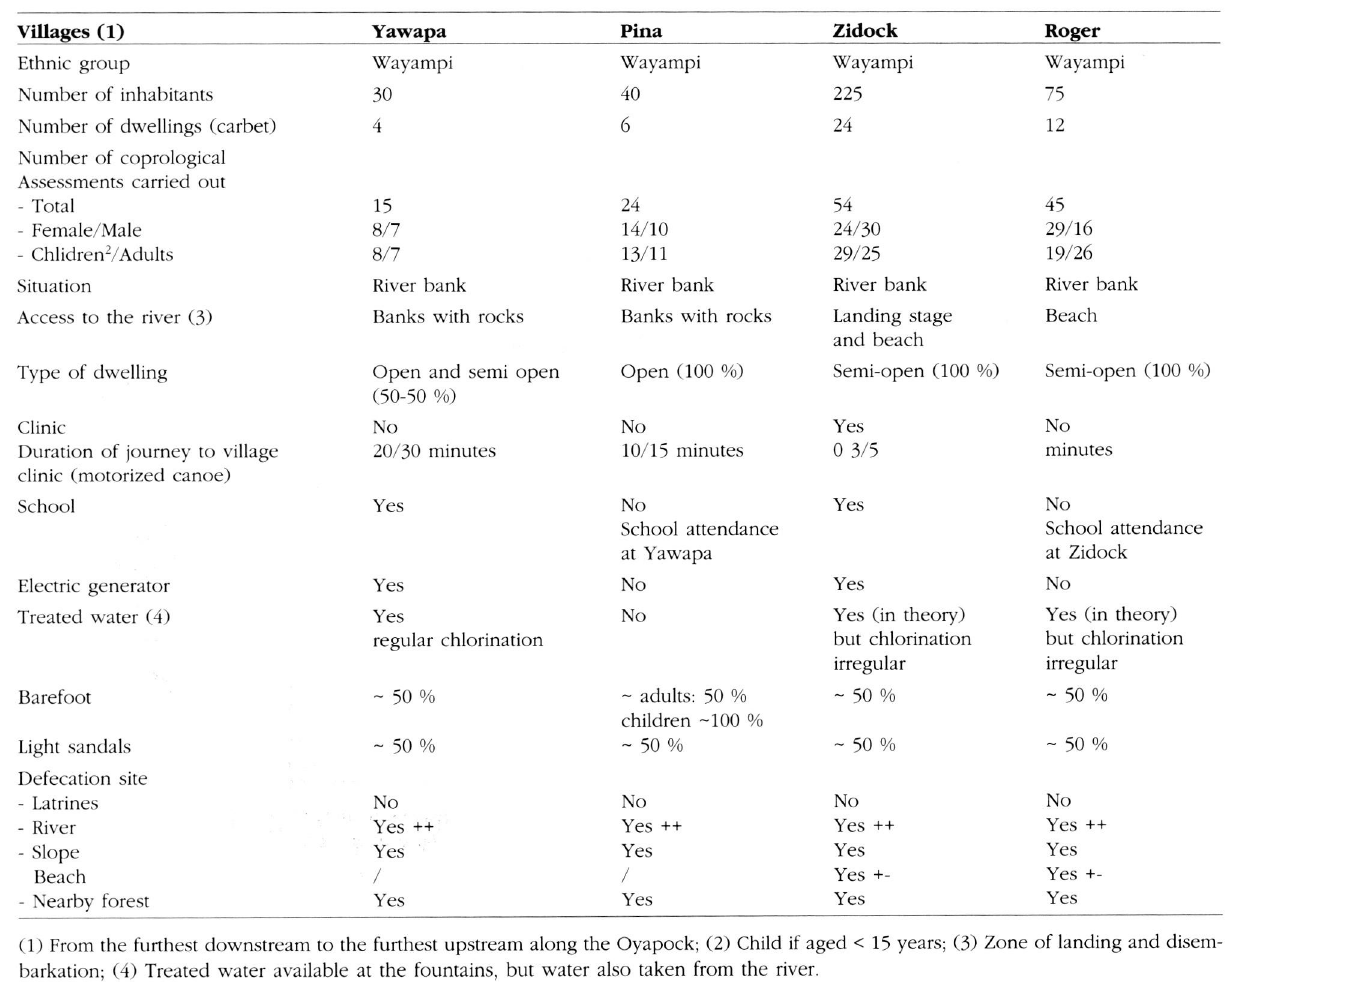
Table I. - Total population, study population and characteristics of the four villages of Trois